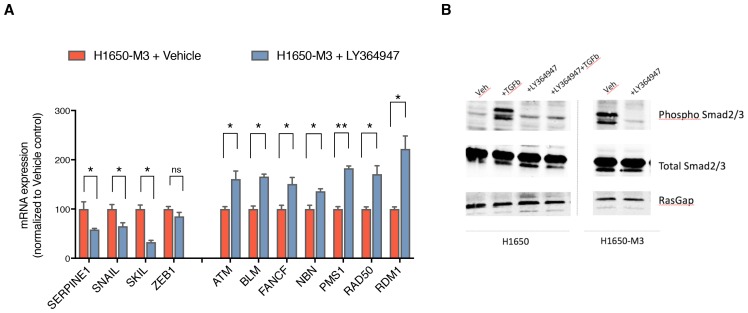
Inhibition of TGF-β signaling in the CD44+/CD24− H1650-M3 cells results in an increased expression of HDR genes.(A) TGF-β receptor 1 (TGFBR1) kinase activity was blocked by treatment with 1 uM LY364947 (Selleckchem) for 48–72 hr. Expression of TGF-β signature genes were used as a control for the efficacy of LY364947 treatment. mRNA expression was quantified through SYBR-green-based RT-qPCR. Each bar represents the mean ± SD of three replicates from two independent experiments (p-value *<0.05, **<0.005 paired t-test). (B) Western blot analysis of H1650 and H1650-M3 cells treated with LY364947 (1 uM) shows that the inhibitor specifically inhibits TGF-β signaling, as phosphorylation of Smad2 and Smad3 are repressed after 48 hr of treatment.